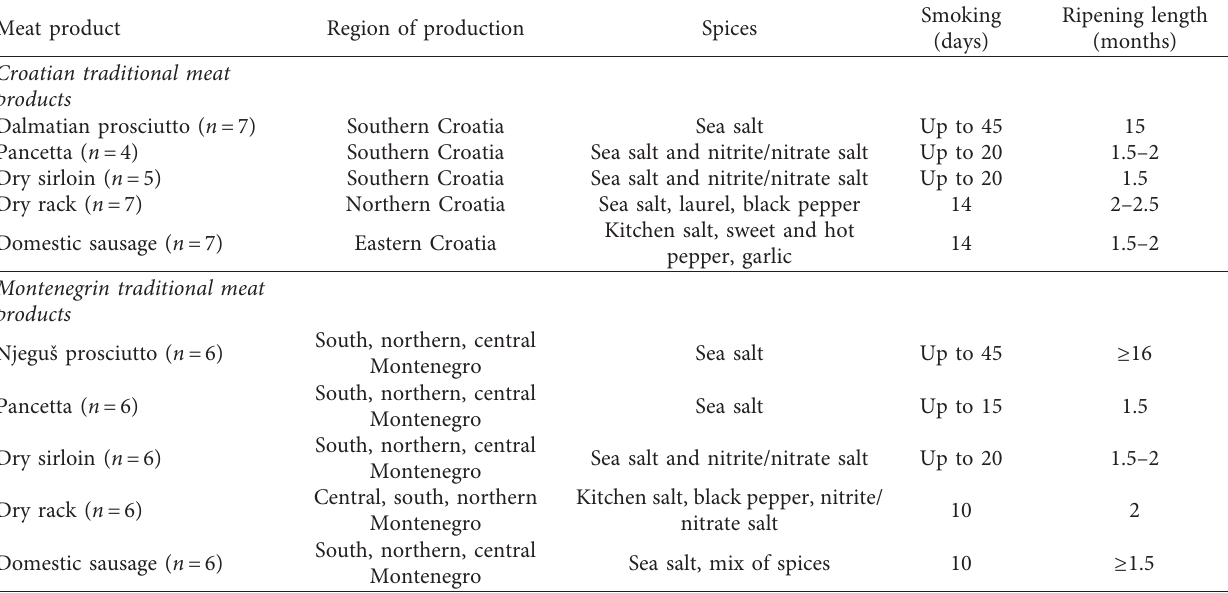
Table 1: Production technology applied with Croatian and Montenegrin traditional dry-cured meat products and dry-fermented sausages. Meat